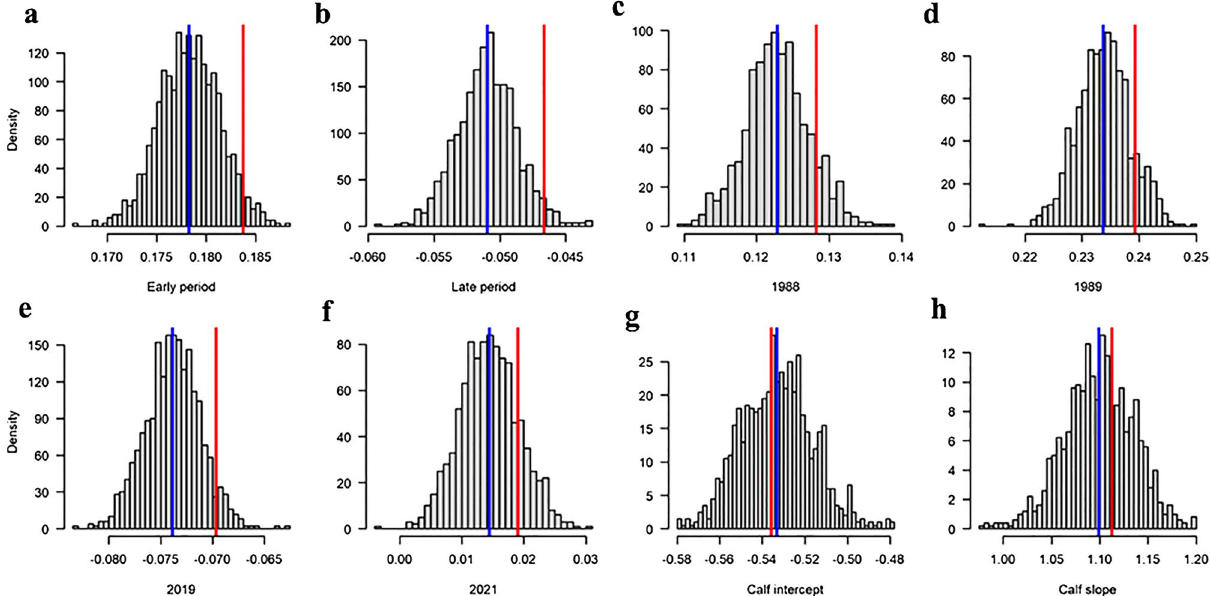
Figure 4. Output of the sensitivity analysis of measurement errors (width measurability errors and between picture measurement errors), showing the density distribution of the model parameter values for ( a , b ) the effect of period on maternal body condition (Model 2 in Table 2), ( c – f ) the effect of year on maternal body condition (Model 3 in Table 2), and ( g , h ) the intercept and slope parameter of the linear relationship between calf body condition and calf relative body length (Model 4 in Table 3). The vertical blue lines show the mean parameter values of the sensitivity analysis. The vertical red lines show the original parameter